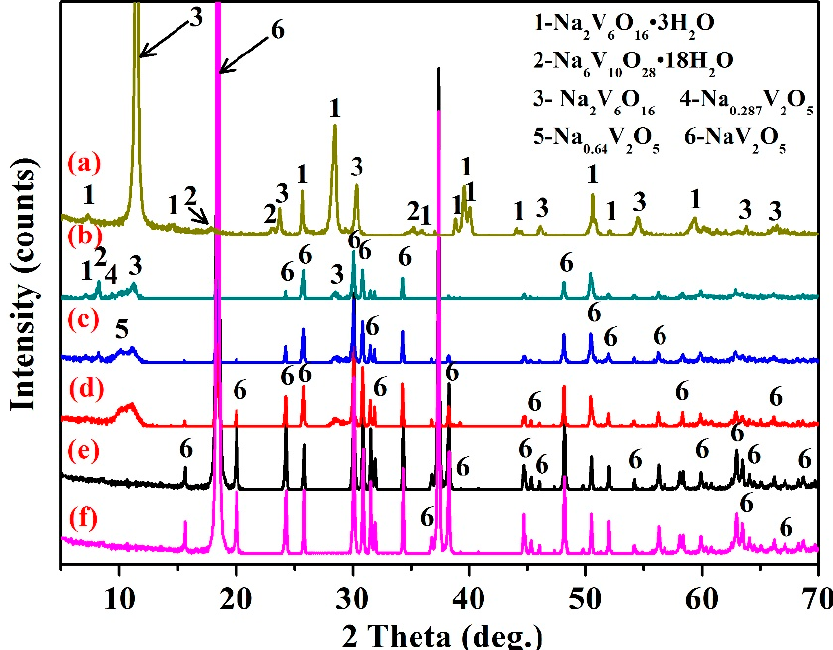
Figure 10. The phase compositions of the products obtained at ( a ) 0 h, ( b ) 0.5 h, ( c ) 1.0 h, ( d ) 1.5 h, ( e ) 2 h, and ( f ) 4 h under an initial solution pH value of 4, a reaction temperature of 200 ◦ C, and a H 2 gas partial pressure of 4 MPa.